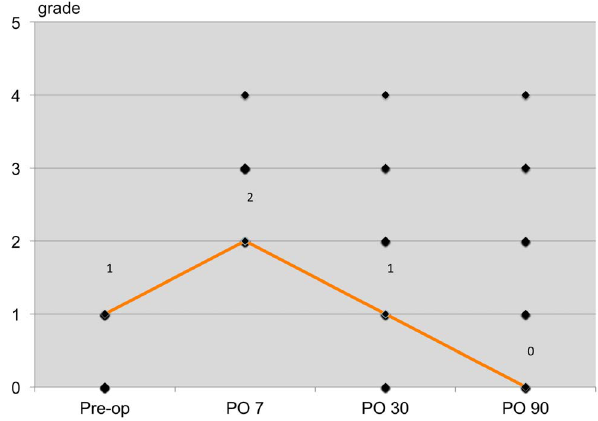
Figure 2. Pattern of dry eye after post-operation according to the OSDI scores. The mean OSDI scores at day 7, months 1 and 3 after surgery were 33.87, 17.34 and 16.88 scores respectively.